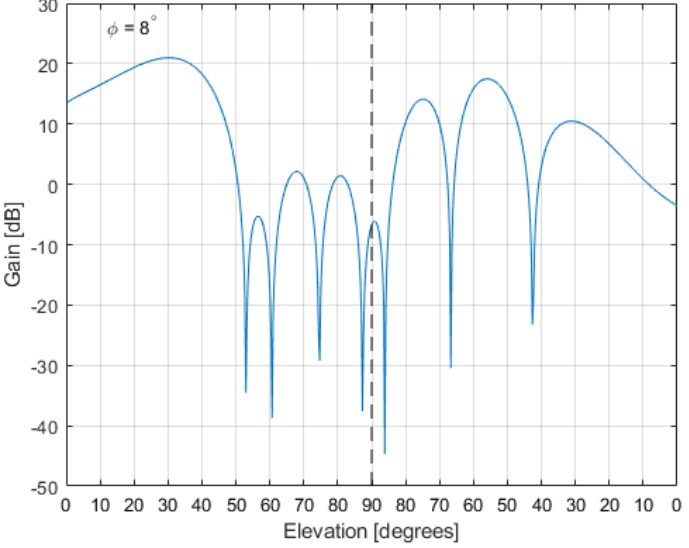
Figure 9. Vertical cut at 8 ◦ azimuth of the beam pattern of the LOFAR tile with the beam steered at φ til = 8 ◦ and θ til = 20 ◦